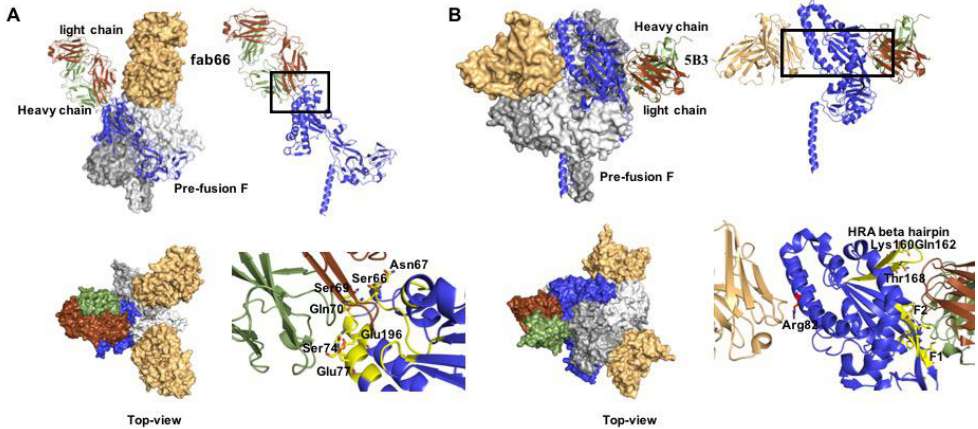
Figure 5. Co-crystal structures of prefusion NiV F with nAbs fab66 and 5B3. ( A ) Side and Table 66. bound to the apex region of the NiV prefusion F trimer (PDB 6T3F). Right panels show a close-up of the epitope, interacting residues are denoted as yellow sticks. ( B ) Side and top view of 5B3 bound to the lateral site of prefusion NiV F (PDB 6TYS). Two F monomers are engaged simultaneously in the interaction. Right panels: both heavy and light chains (depicted in green and brown, respectively) interact with the F protein.